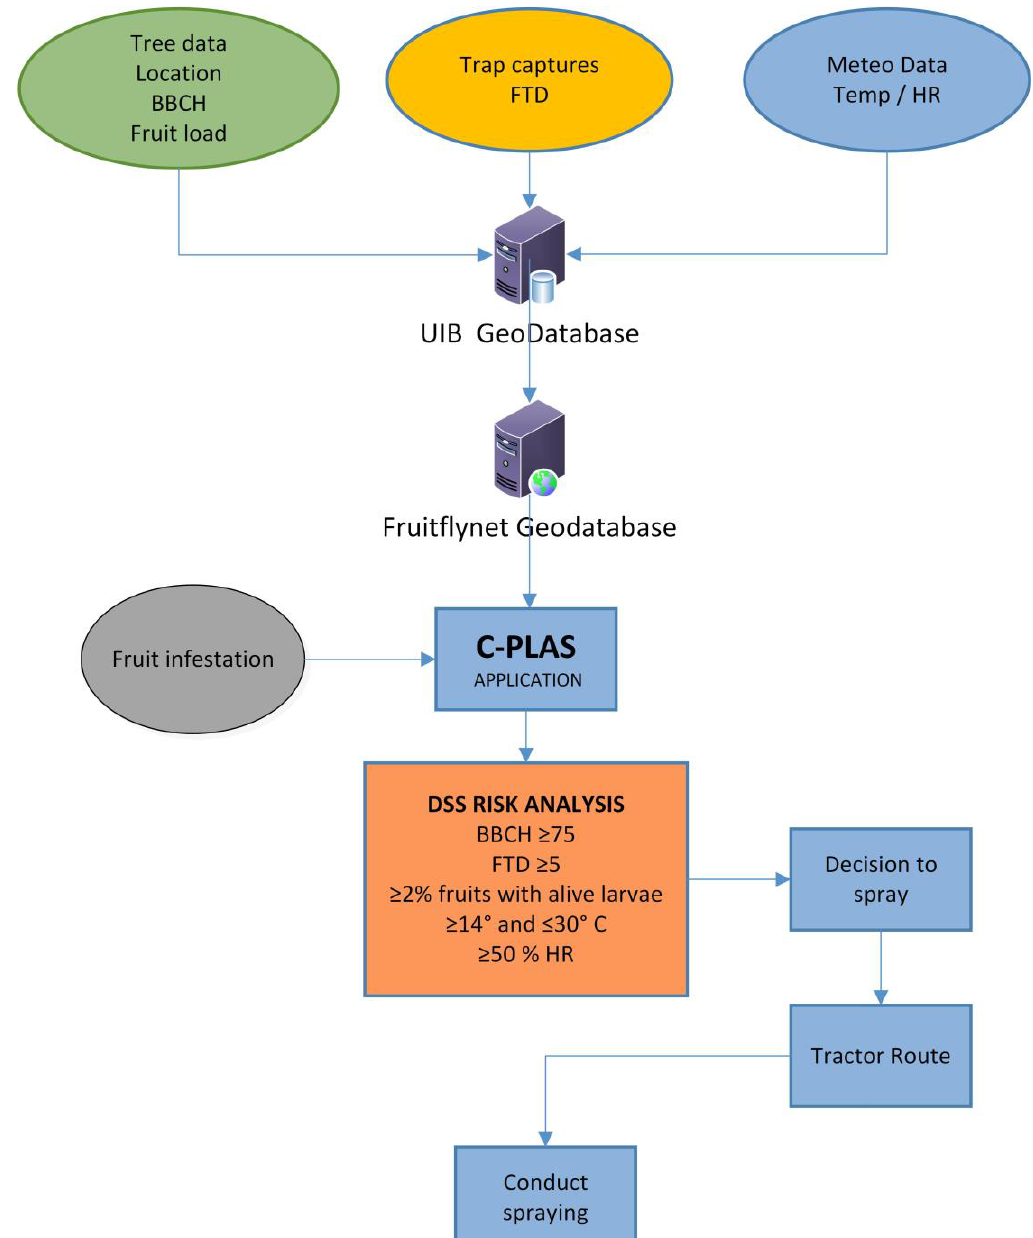
Figure 8. Decision support system input-output diagram. The relational database compiles information from trees (position, phenology BBCH, and fruit load), captures (e-traps), and meteorological data (HR% and daily average temperature). The di ff erent parameters are collected at field level and uploaded to the UIB geodatabase. This database transfers data to the FruitFlyNet geodatabase that feeds the C-PLAS software that estimates levels of risk for the LAS plots according to the parameters considered to make a decision to spray (DSS risk analysis). Once decision is made, C-PLAS estimates a tractor route for the di ff erent LAS plots and spraying can be